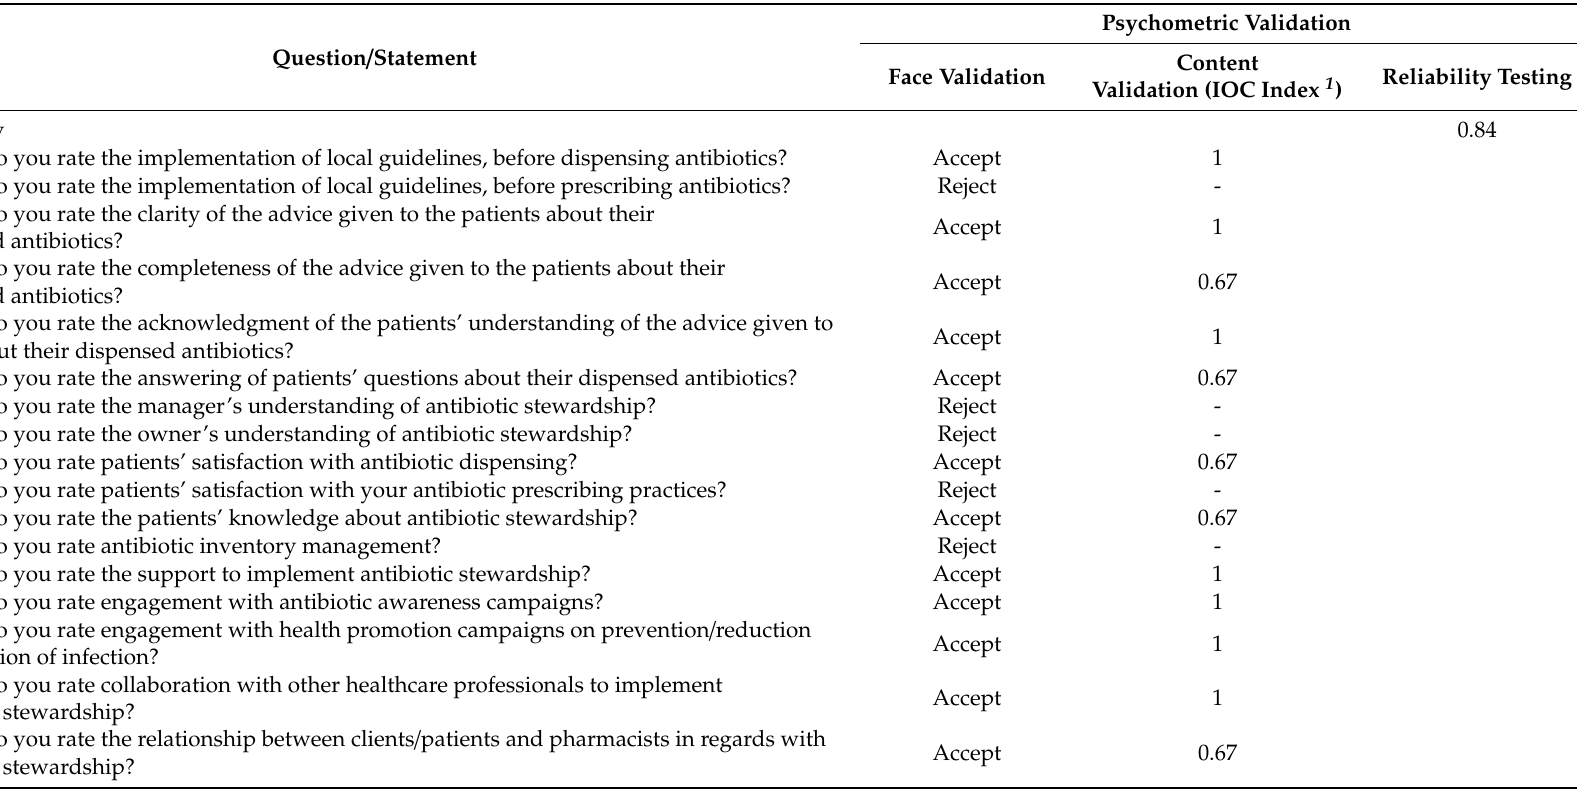
Table 2. Lists of Items of Attitude Domain of the Survey